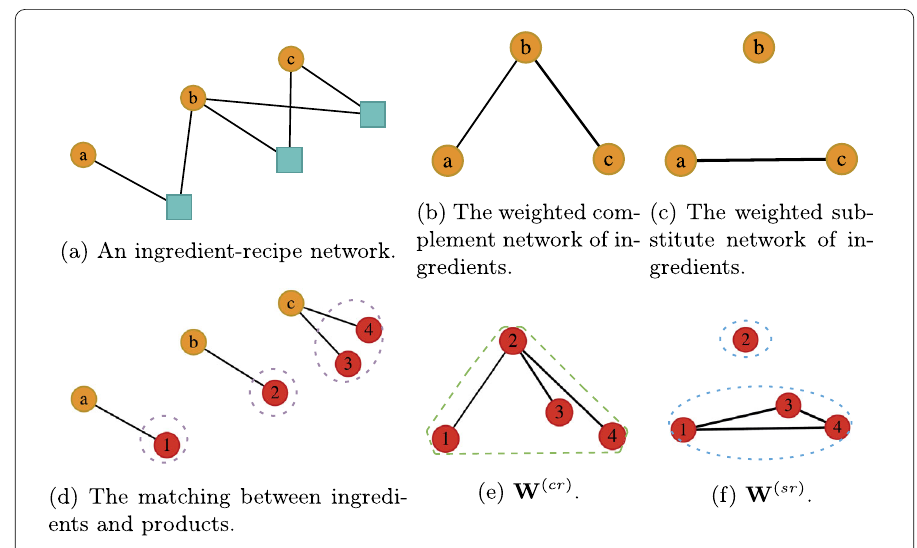
Figure 3 Illustration of the process to compute the product roles from the recipe data, where cyan squares are recipe nodes, orange circles are ingredient nodes, red circles are product nodes, the line thickness corresponds to how high the corresponding scores are, and l 0 substitute roles, l complement role(s) and l 1 substitute roles are shown as groups of product nodes in the purple dashed circles, green dashed polygon(s) and blue dashed circles,